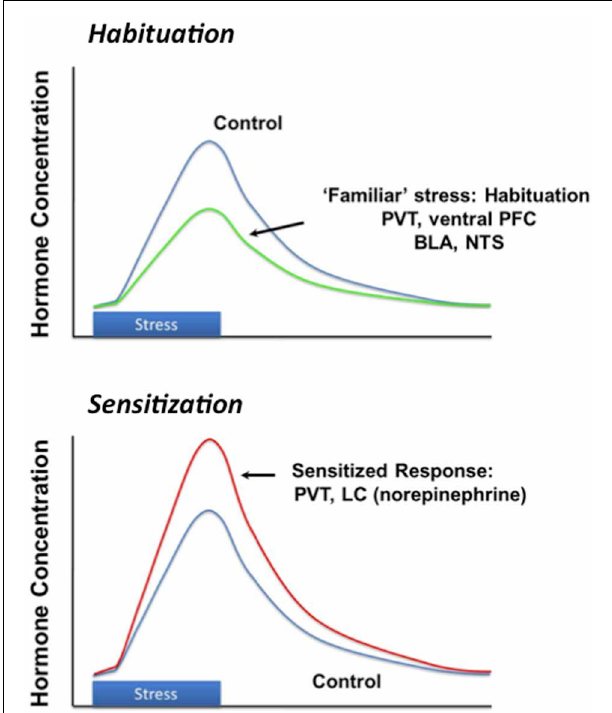
FIGURE 3 | Stress habituation and facilitation. Repeated exposure to the same stressor results in progressive diminution of response magnitude, thought to be mediated by structures such as the prefrontal cortex (PFC) and paraventricular thalamus (PVT). Exposure to a new stressor after either homotypic or hetertypic stressors causes a larger than normal (“sensitized’ or “facilitated’ response), which may be mediated by enhanced drive from the basolateral amygdala (BLA), PVT or locus coeruleus